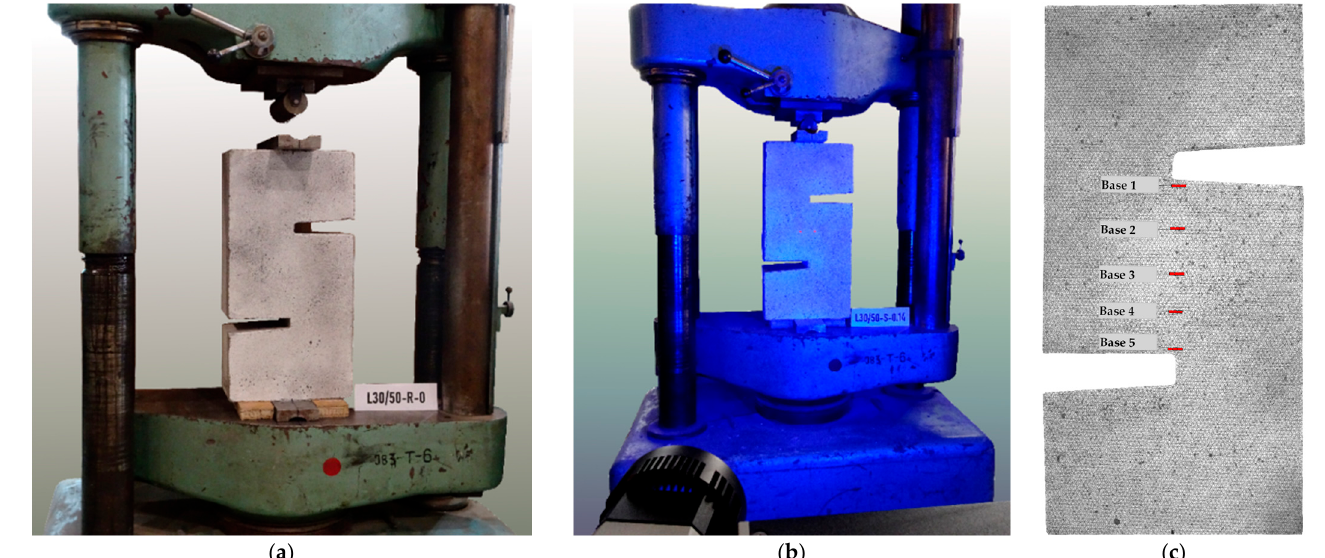
Figure 3. Details of the test specimens and the test setup (all dimensions in mm).